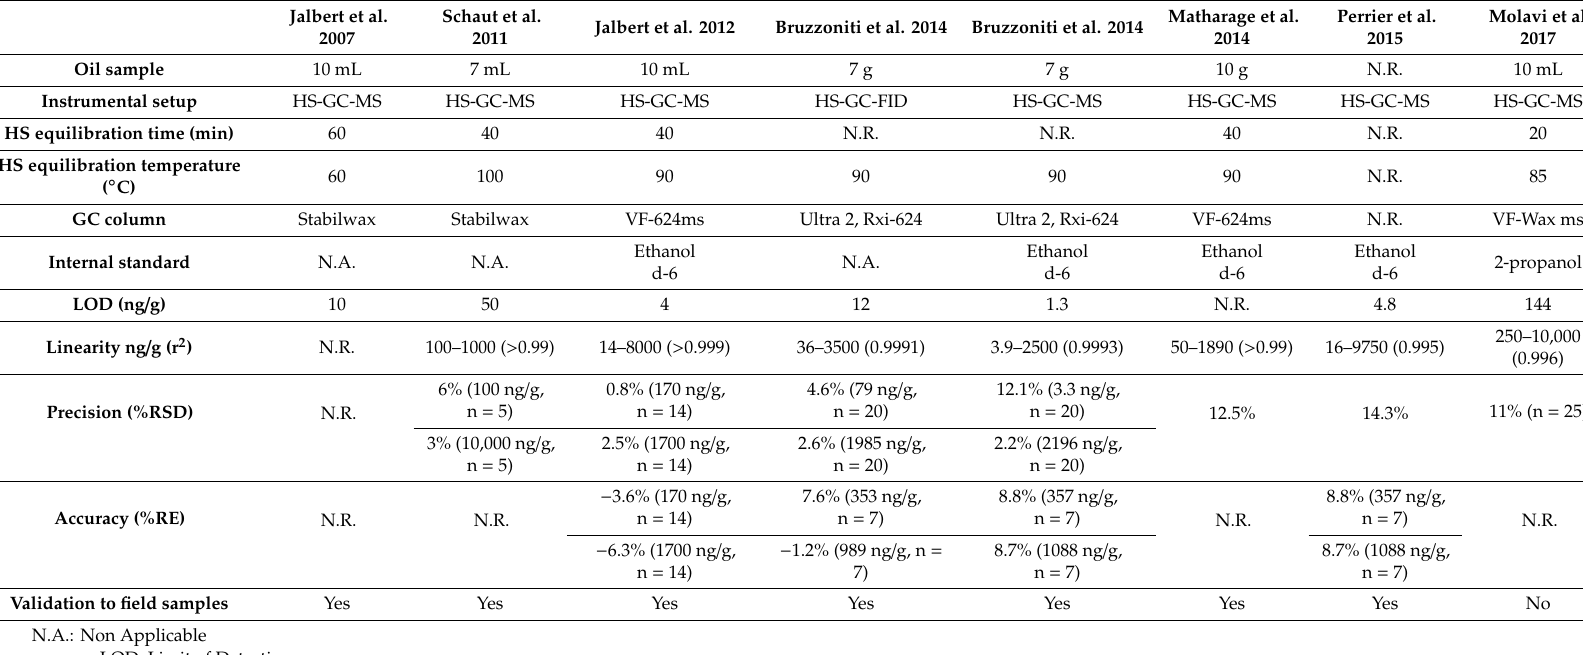
Table 1. Characteristics of the available methodologies for the determination of alcohols in transformer